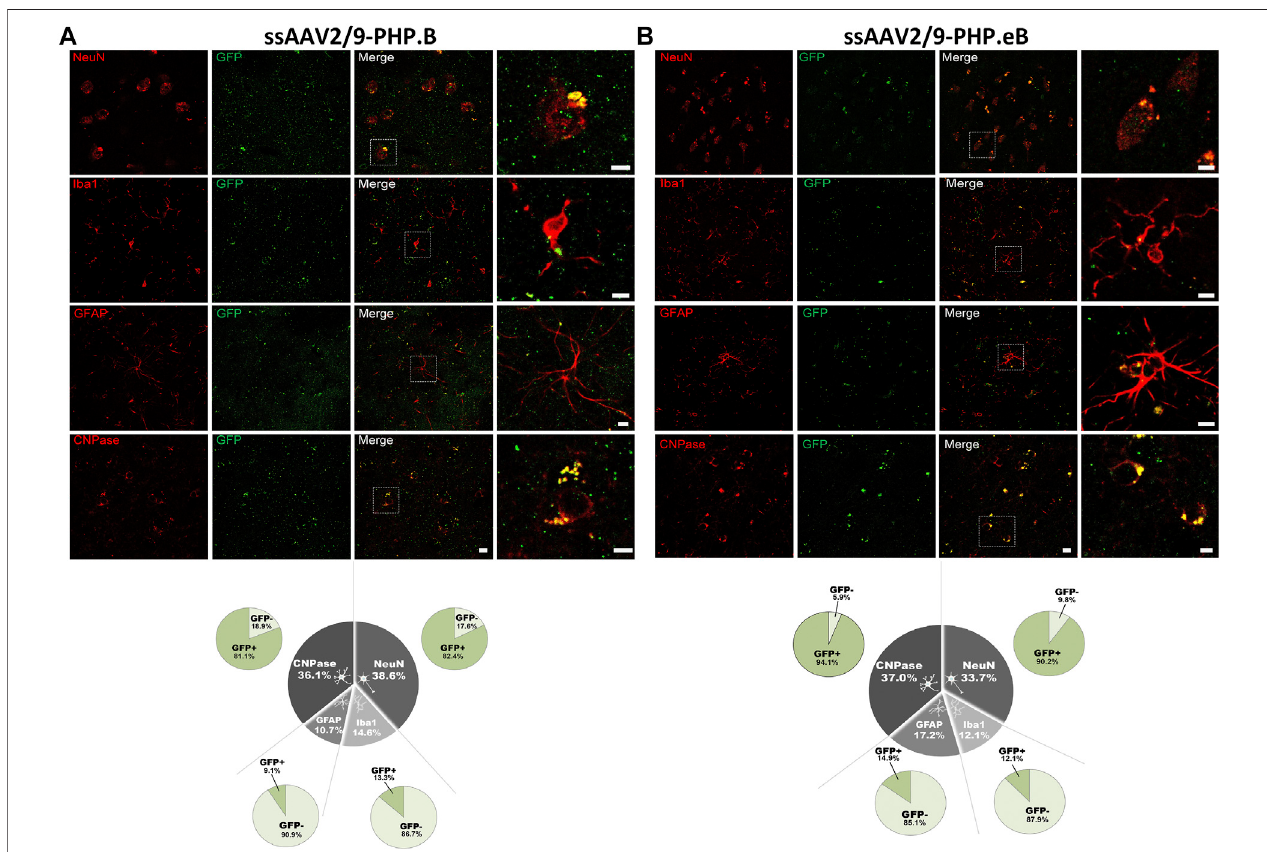
FIGURE 4 | Neuronal cell-type speci fi city resulting from AAV-PHP. B and AAV-PHP. eB injections in the putamen of non-human primates. (A – B) Representative images (top) and quanti fi cations (down) of striatal sections from AAV-PHP. B-injected monkey (A) and AAV-PHP. eB-injected monkey (B) immuno fl uorescently labeled withanti-GFPantibody(green)andeitheraneuronal(NeuN),microglia(Iba1),astrocytic(GFAP+S-100)oroligodendroglial(CNPase)marker(red).Mergingofthesignals produced colocalization, thus con fi rming cellular transduction. Scale bar: 20 µm; 10 µm (high magni fi cation). Quantitative analysis of percentage of cell types counted for each viral vector in the putamen of injected monkeys (grey) and percentage of cells transduced (dark green) or not (light green) per cell type.